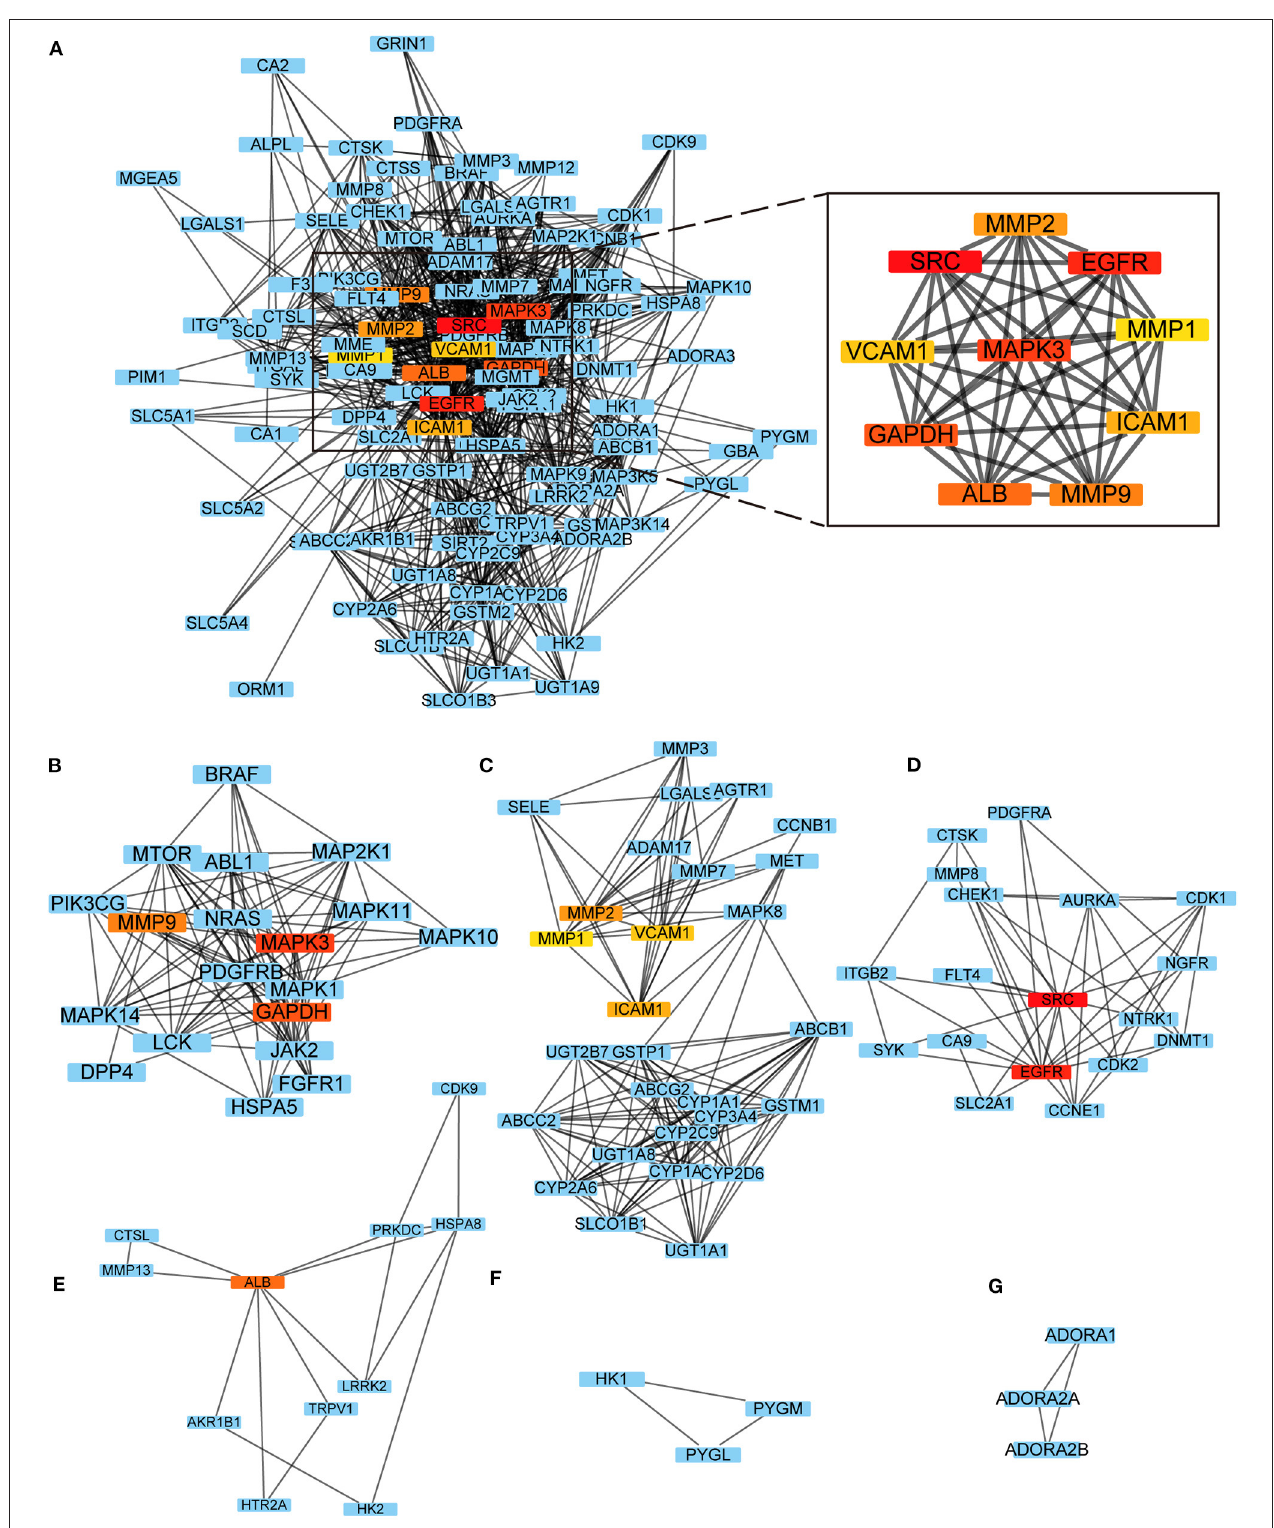
FIGURE 2 | PPI network. (A) Top 10 key targets in the PPI network obtained by the Cytohubba; (B–G) The results of the MCODE plug-in clustering analysis.